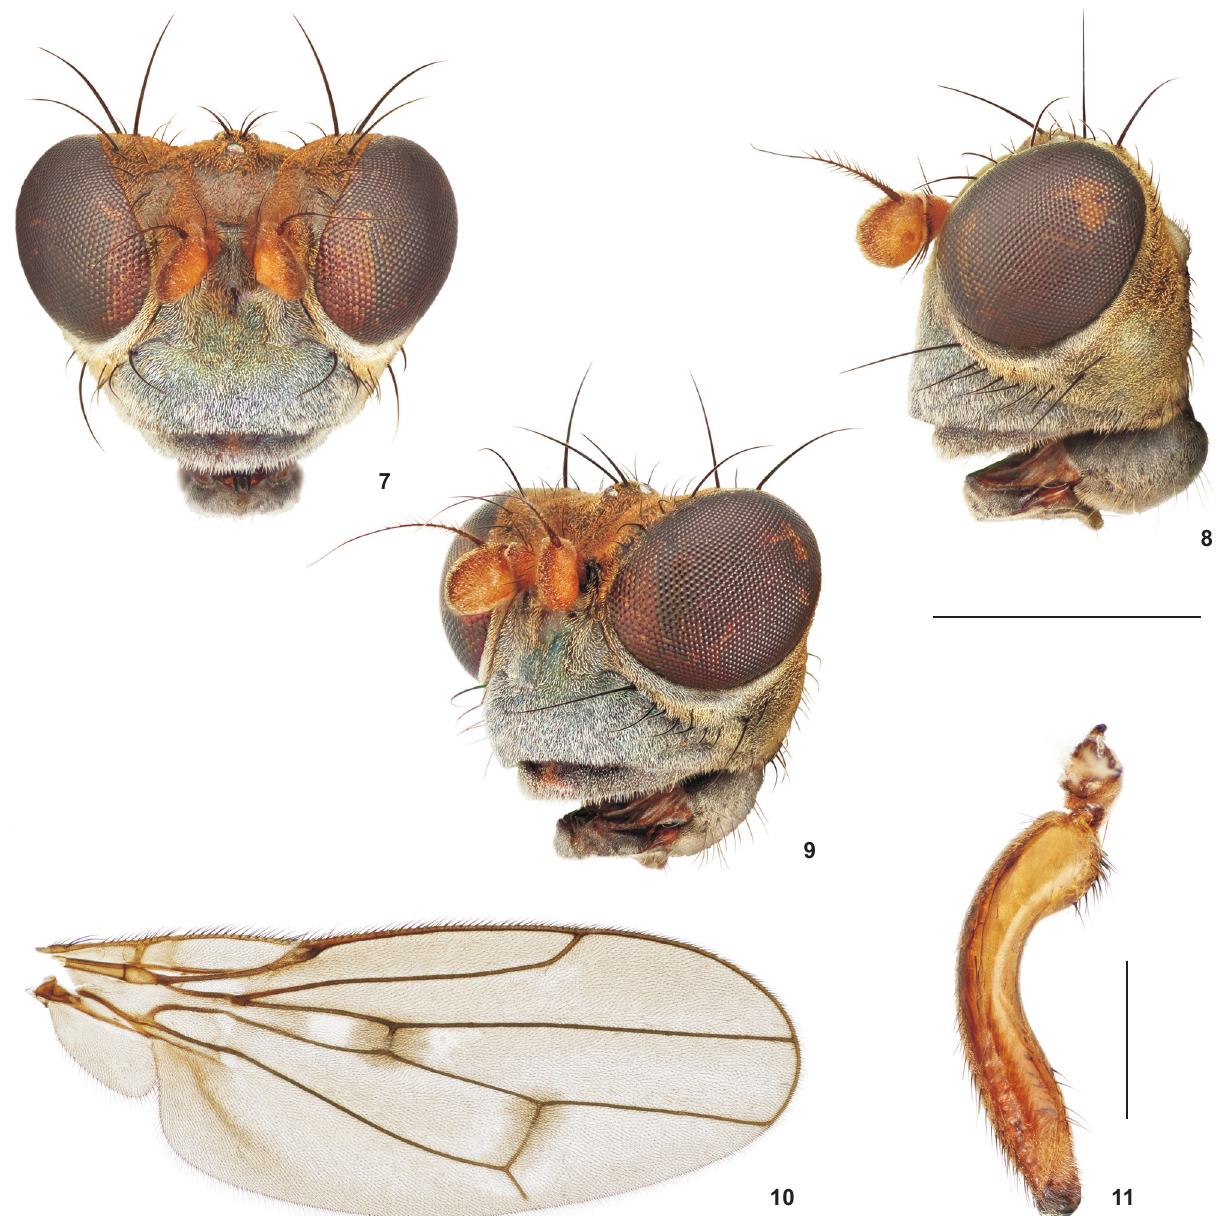
Figures 7-11. Parydra arcuata sp. nov. : (7) head, anterior view; (8) same, lateral view; (9) same, oblique view; (10) wing, dorsal view; (11) hindfemora, posterior view. Scale bars: 0.5